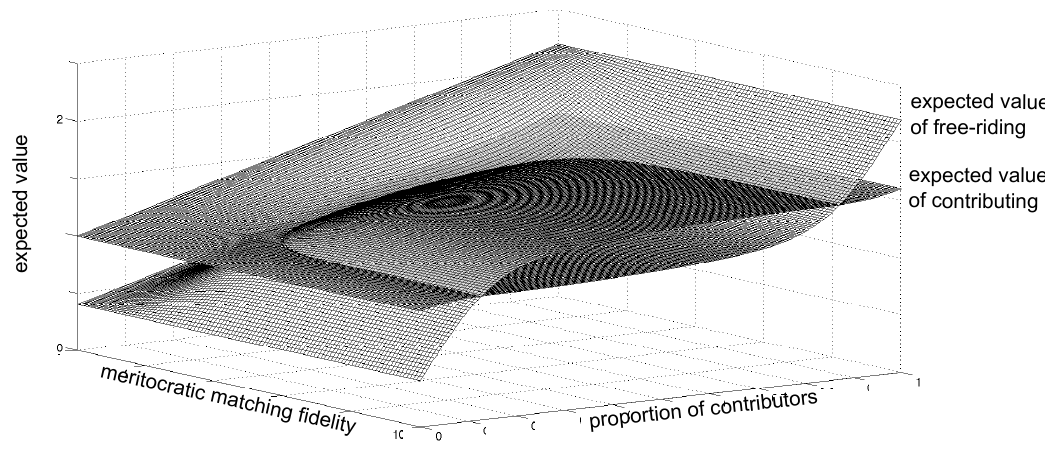
Figure A2. The figure depicts the expected payoffs of contributing versus free-riding for the economy with n = 16, s = 4, r = 1.6. The expected values of φ i ( 0 | 1 p − of contribution probability p and meritocratic matching fidelity β . The two planes intersect at the bifurcating symmetric mixed-strategy Nash equilibrium-values of p and p (see Proposition A10). Notice that the expected values of both actions increase linearly in p when the meritocratic matching fidelity is zero, but turn increasingly S-shaped for larger values, until they intersect at p and p